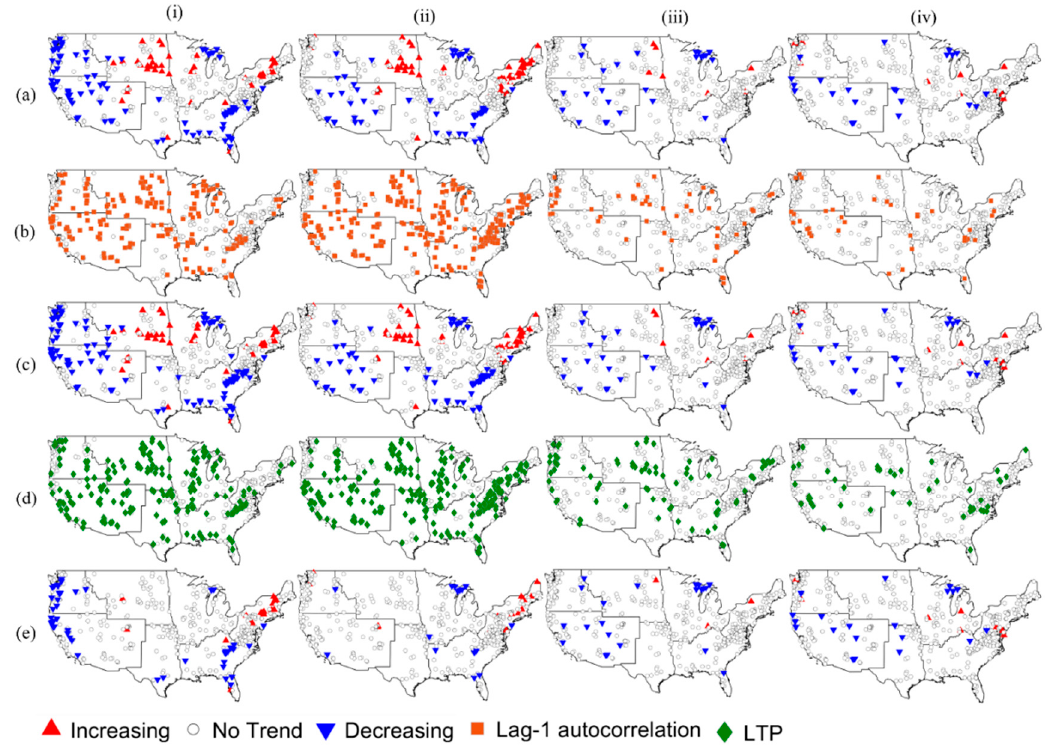
Figure 4. Maps showing results for trend, lag-1 autocorrelation, and long-term persistence (LTP) for ( i ) 5th percentile, ( ii ) 50th percentile, ( iii ) 95th percentile, and ( iv ) 100th percentile streamflow. Row ( a – e ) summarizes MK1, Lag-1, MK2, LTP and MK3 results, respectively. All the stations showing a (positive / negative) trend at the statistical significance of p ≤ 0.05 are represented by the (upward / downward) triangles. Square and diamond markers represent the stations showing lag-1 autocorrelation and LTP, respectively. Circles represent the absence of a trend, lag-1 autocorrelation and LTP.